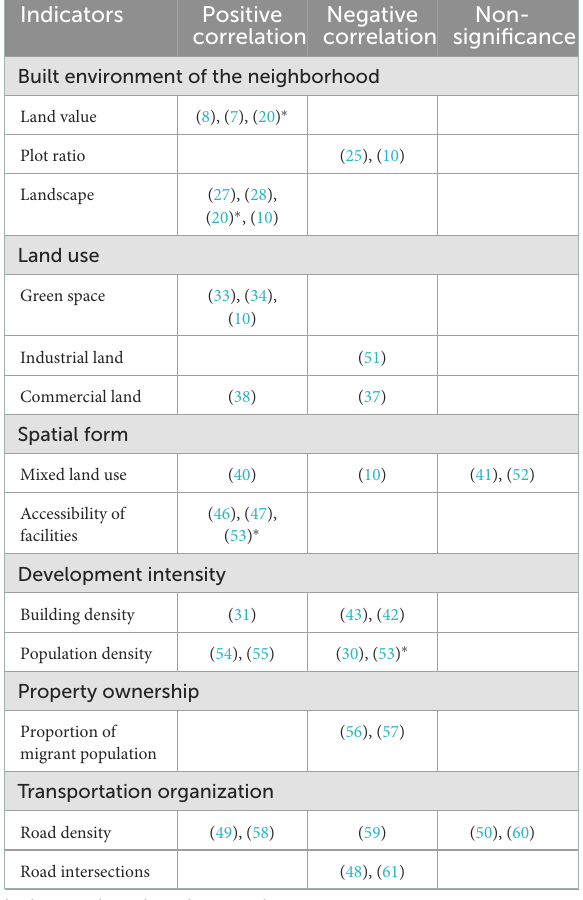
TABLE 1 Studies of the relationship between the built environment and residents’ sentiments. Indicators Positive Negative Non- correlation correlation